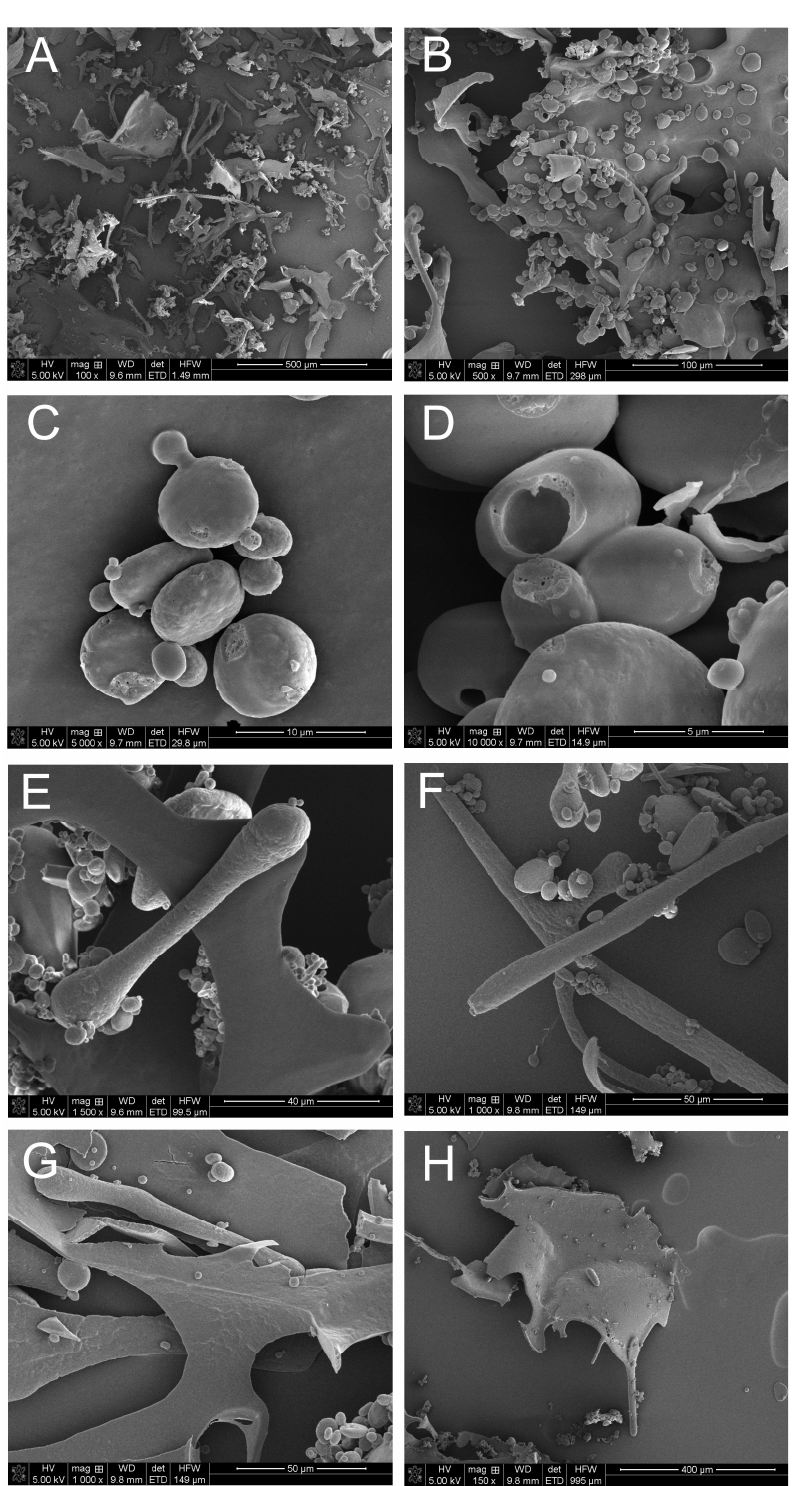
Figure 10. SEM micrographs of S. hermaphrodita seed extract: ( A , B )—general image of the extract; ( C , D )—spherical structures visible in the microscopic image of the extract; ( E , F )—rod-shaped longitudinal structures; ( G , H )—flat structures.